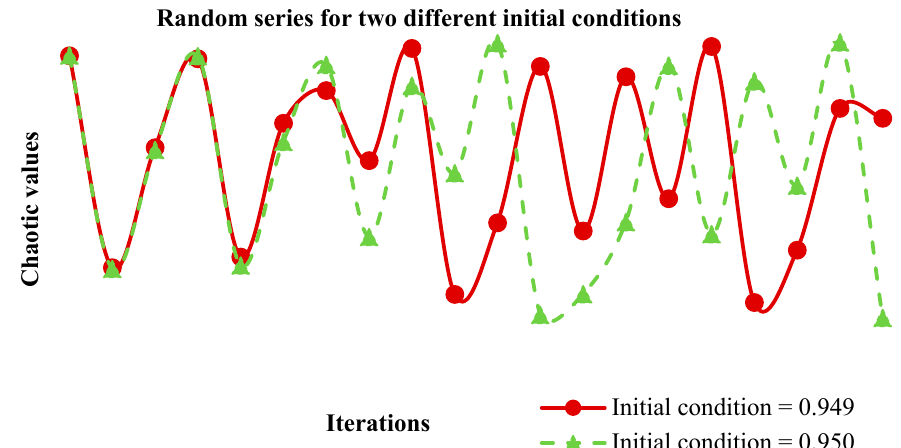
Figure 1. Random series for two different initial conditions.